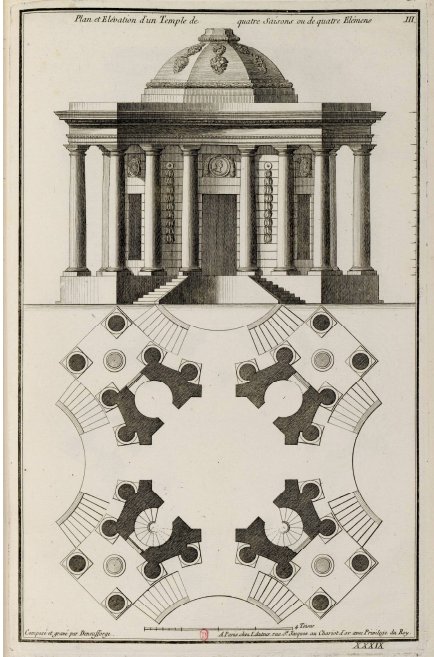
Figure 2. Plan and elevation of a temple of the four seasons and four elements. Supp. I, cap. XXXIX, p.